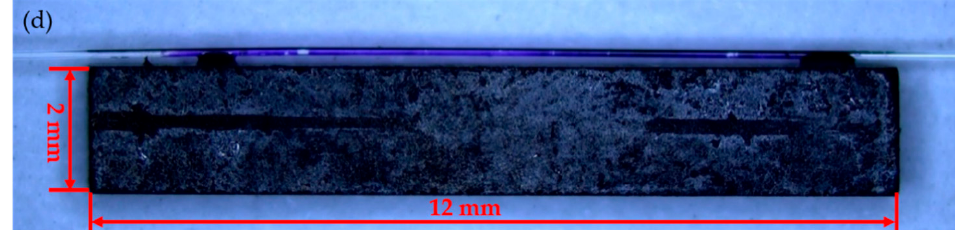
Figure 1. ( a – c ) Fabrication process schematic diagram of the proposed sensor. ( d ) Microscope image of the side view of the fabricated sensor.